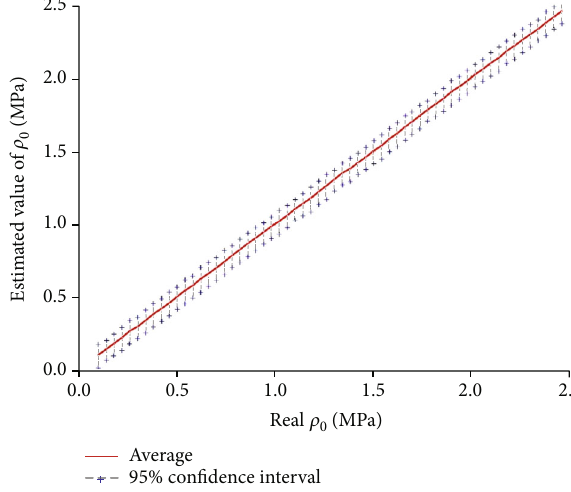
Figure 5: The distribution of estimated initial underbalance pressure (noise level: 0.1m 3 ).